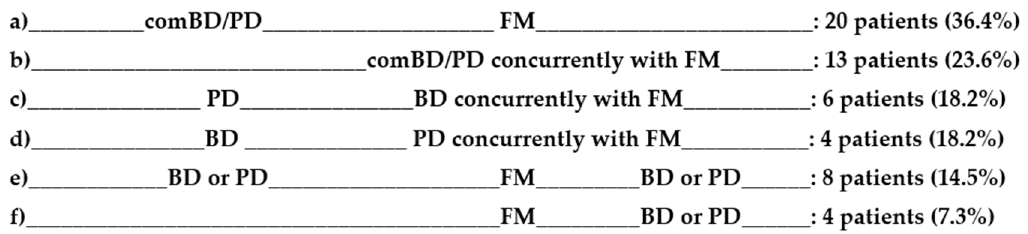
Figure 1. ( a ) Prevalence of threshold comBD / PD; ( b ) Prevalence of threshold + subthreshold comBD /